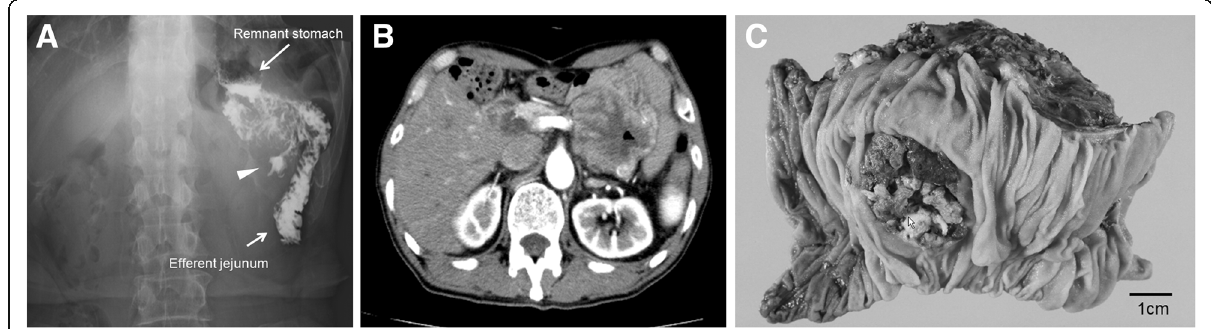
Fig. 1 Pictures before surgery. a Upper gastrointestinal series revealed the presence of contrast medium in the ulcerative lesion from the afferent jejunum. b Abdominal contrast-enhanced computed tomography revealed a 70-mm mass at the mesentery of the jejunum. c A 75 × 70-mm- sized mass was found at the mesentery of the jejunum with infiltration of all the layers of jejunum wall in the resected